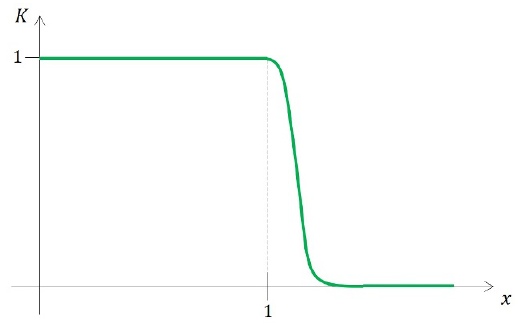
Figure 1 . Example of an appropriate K ( x